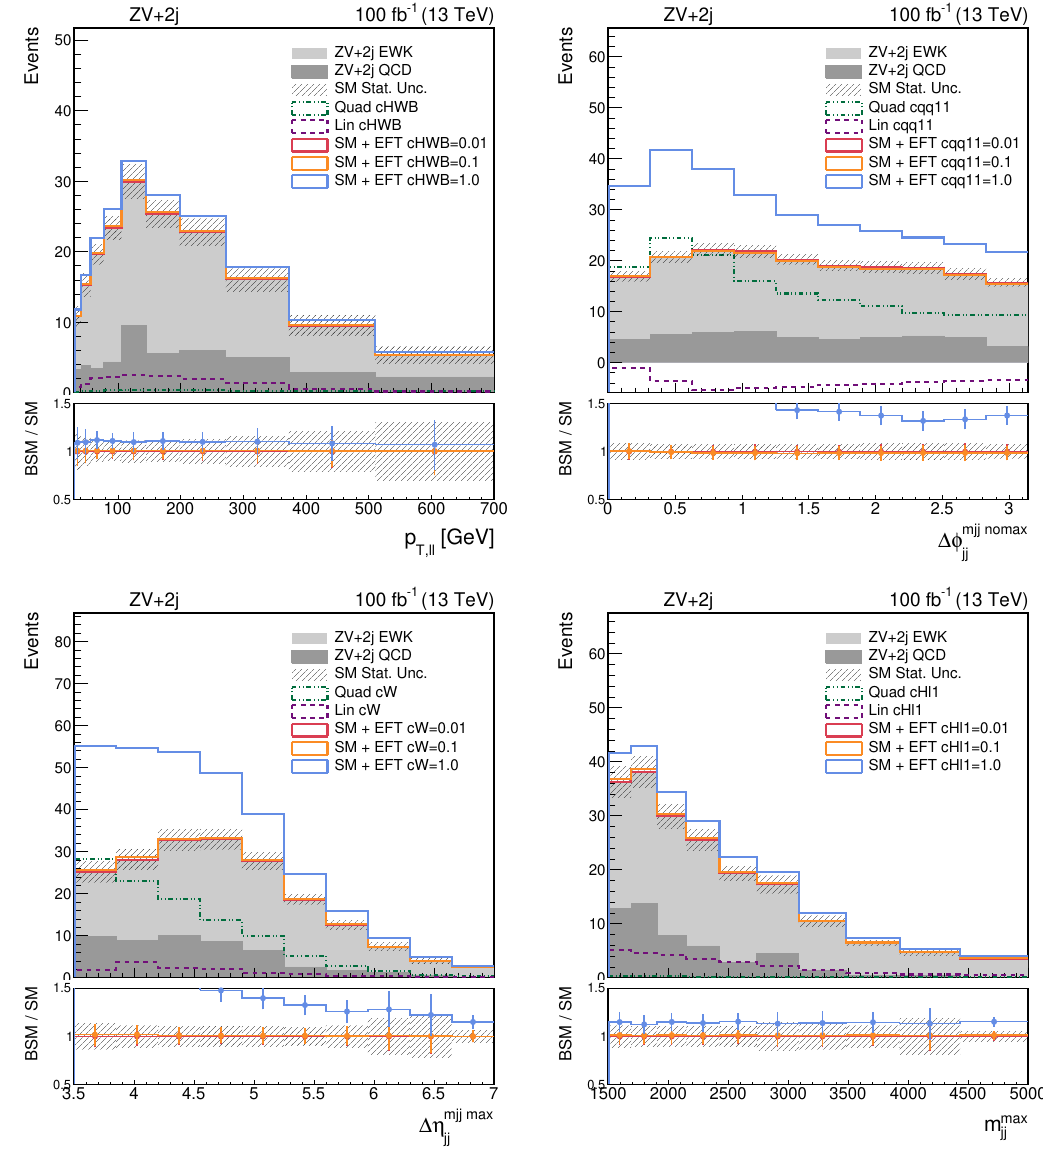
Figure 16 . Comparison of SM (filled histograms) and BSM (lines) expected number of events after the event selection in table 4, for various observables and Wilson coefficients in the ZV+2j-EW and ZV+2j-QCD processes, at an integrated luminosity of 100 fb − 1 . The SM distribution is represented as a stacked histogram, summing EW (light grey) and QCD (dark grey) components. Solid lines show the total prediction for one Wilson coefficient at a time, with c 1 TeV − 2 (blue). The pure interference (quadratic) EFT component, normalized to c is indicated with a purple (green) dashed line. For all distributions, the last bin comprises all the overflow